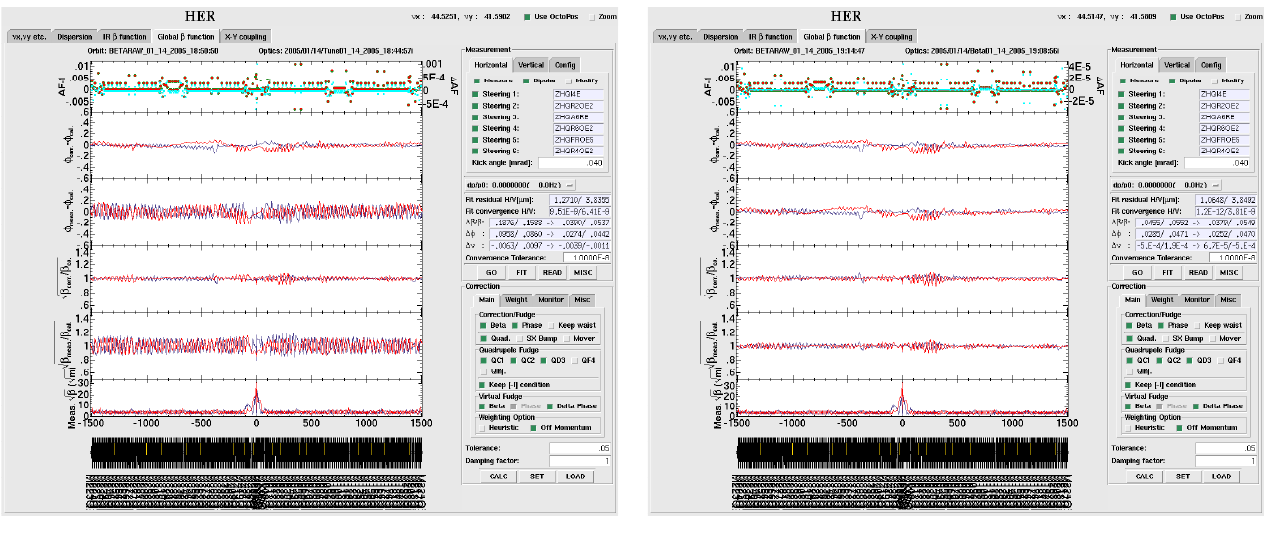
FIG. 2. (Color) Results of the beta measurement before (a) and after (b) the correction. In the first row of the graphs, the current and are shown by green and red points, respectively. The measured value of the phase advance error and the square- desired values of a f root ratio of the beta function are shown in the 3rd and the 5th rows, respectively. The 2nd and 4th rows show a prediction after the correction. In these graphs, the blue and red lines correspond to the horizontal and vertical optics functions,